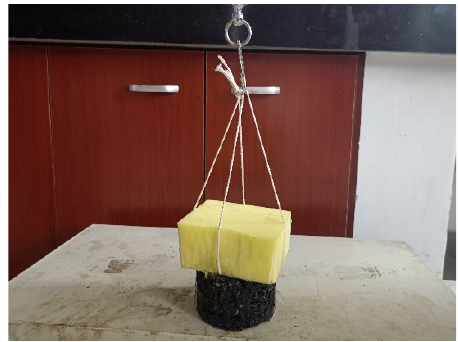
Figure 4. Interface adhesion test.